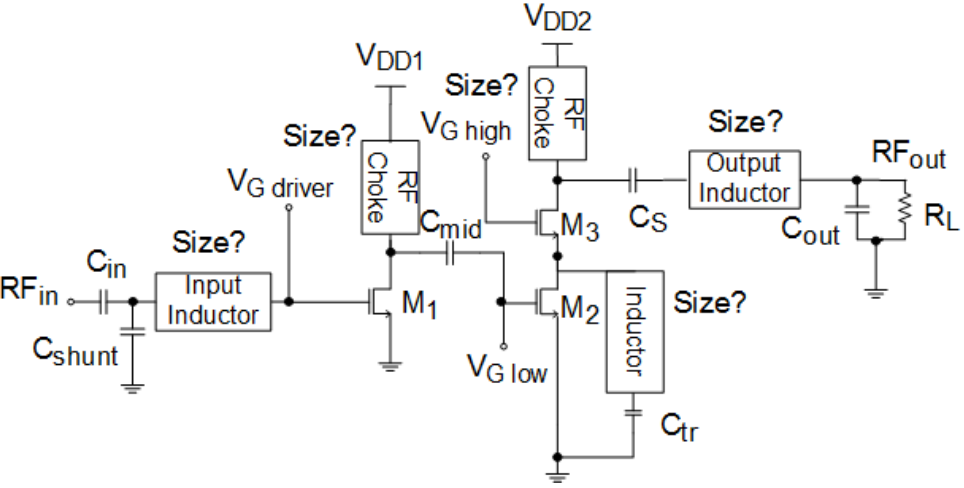
Figure 13. Schematic of the Class E power amplifier without metal6.